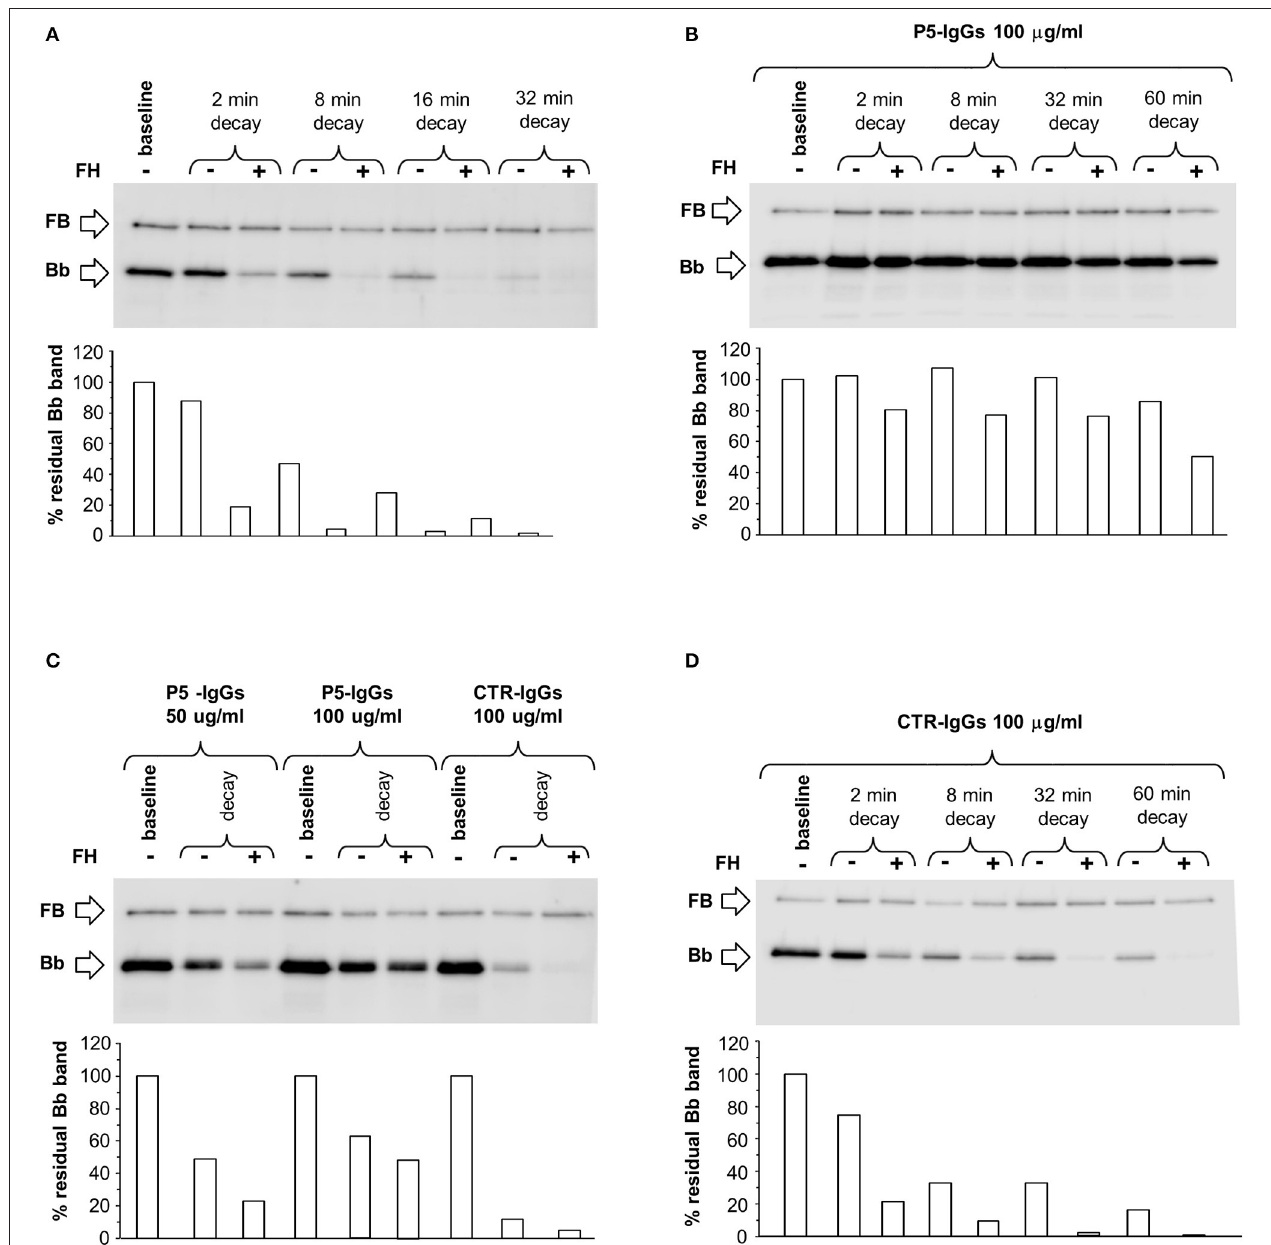
FIGURE 1 | Spontaneous and FH-mediated decay of the C3bBb(Mg 2 + ) C3 convertase in the absence or in the presence of IgGs from a DDD patient or a healthy control, by microplate/Western blot (WB) assay. (A) Time course of spontaneous and FH-mediated decay of C3bBb(Mg 2 + ). The complexes were formed by incubating for 12min at 25 ◦ C C3b-coated wells with 1,000ng/ml FB, 10ng/ml FD, and 10mM MgCl 2 (baseline). In additional wells after washing, the formed complexes were further incubated for 2, 8, 16, and 32min in the absence (-) or in the presence ( + ) of 2,640ng/ml FH. (B) C3bBb(Mg 2 + ) was formed in the presence of IgGs from P5 patient with DDD during 12min at 25 ◦ C (baseline). The complexes were allowed to decay for 2, 8, 32, and 60min in the absence (–) or in the presence of 2,640ng/ml FH ( + ). (C) C3bBb(Mg 2 + ) was formed in the presence of IgGs (P5-IgGs, 50, and 100 µ g/ml) from patient 5 or from an healthy subject (CTR-IgGs, 100 µ g/ml) for 12min at 25 ◦ C. Spontaneous or FH-mediated decay was monitored by further incubation for 32min at 25 ◦ C with buffer alone (–) or added with 2,640ng/ml FH ( + ), respectively. (D) C3bBb(Mg 2 + ) was formed in the presence of IgGs from a healthy subject (CTR-IgGs) for 12min at 25 ◦ C. The complexes were allowed to decay for 2, 8, 32, and 60min in the absence (–) or in the presence of 2,640ng/ml FH ( + ). The percentage of residual Bb band (visualized by an anti-FB antibody) was calculated as the ratio of the densities (in Pixel 2 ) of each Bb band after decay and the density of the corresponding baseline Bb band before decay x 100 and results are reported in the bottom graphs. Results of a representative microplate/WB experiment of n = 3 for each sample are shown.